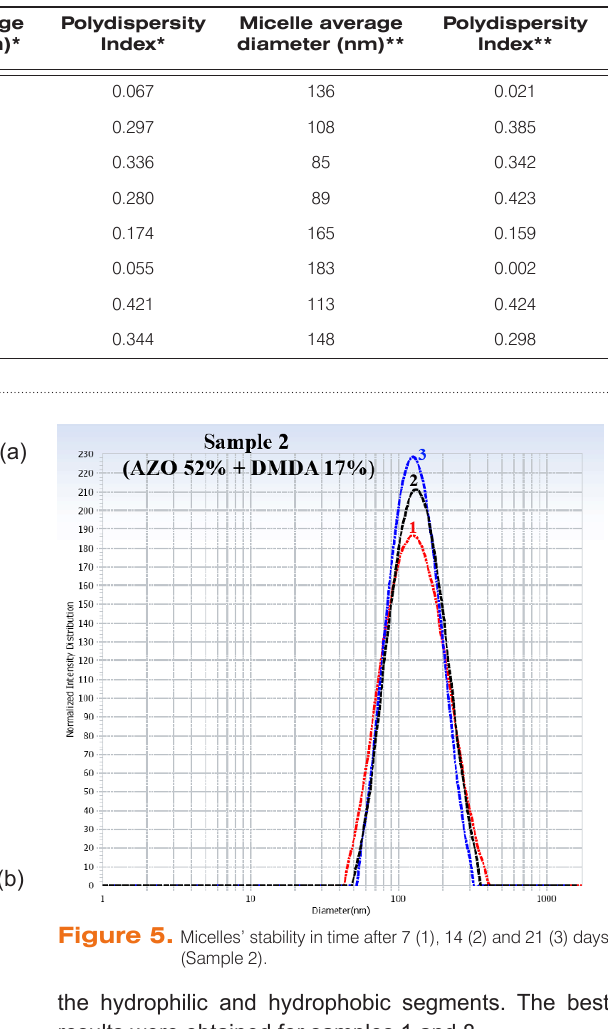
Table 3. Micelles’ diameter as a function of the concentration and chemical structure.